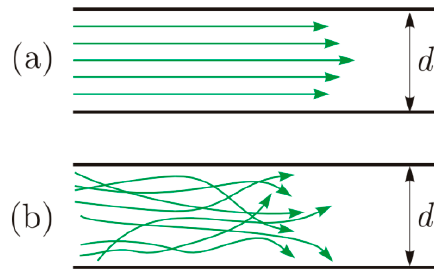
Figure 7. Detectable differences between laminar ( a ) and turbulent ( b ) within the pipeline.